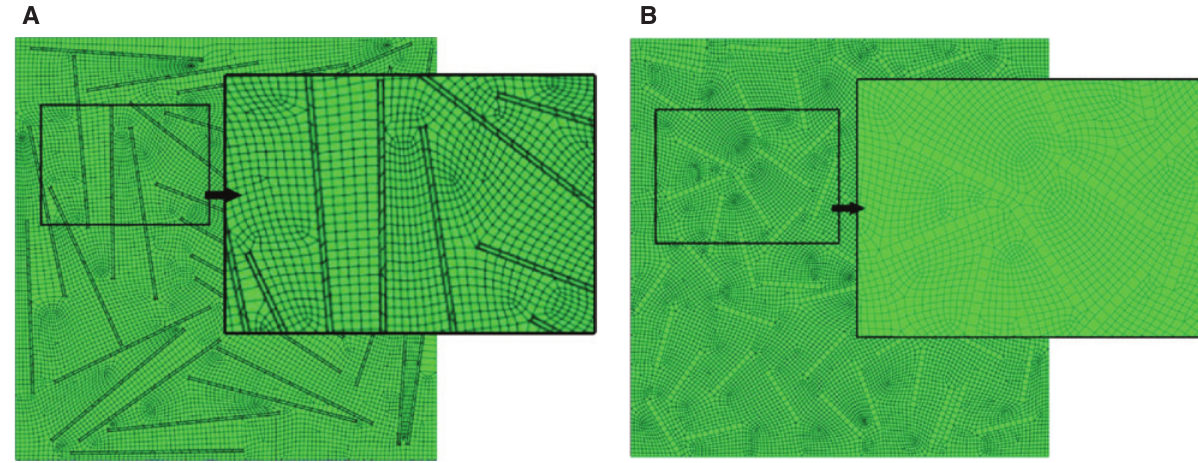
Figure 3: Meshed RVE for (A) CNT-RP and (B)